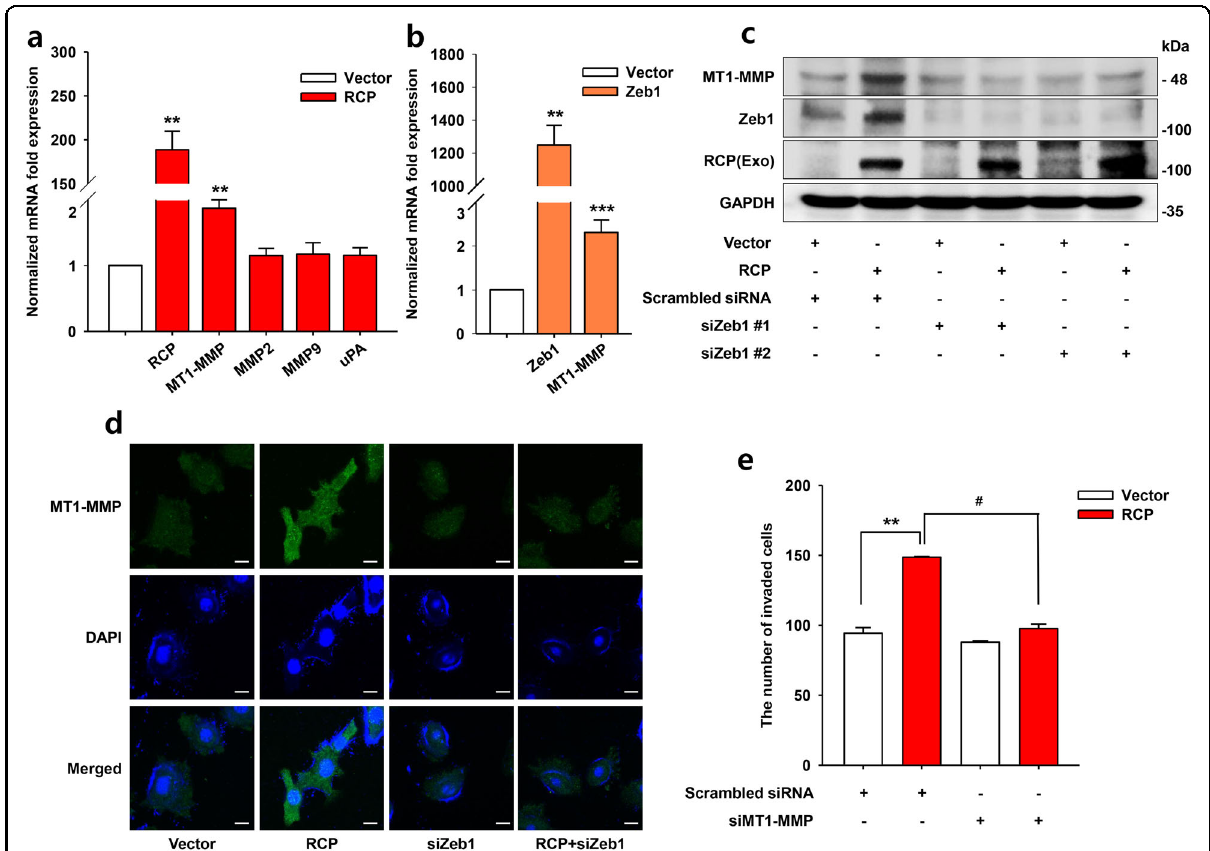
Fig. 5 RCP induces MT1-MMP to promote OSCC invasion. a , b YD-10B cells were transfected with or without ( a ) RCP and ( b ) Zeb1. qRT-PCR analysis of matrix metalloproteinases (MMP2, MMP9, MT1-MMP) and urokinase-type plasminogen activator (uPA) mRNA (error bars, ±SD: *** p < 0.001 and ** p < 0.01 vs control vector). c YD-10B cells were transfected with the indicated vectors and siRNAs. Immunoblotting. d The expression of MT1- MMP was visualized by immuno fl uorescence. Image original magni fi cation, ×600, scale bar, 10 μ m. e YD-10B cells transfected with the indicated vectors and siRNAs. Cell invasion assays were performed with media without any attractant as the control (error bars, ±SD: ** p < 0.01 vs control vector, # p < 0.05 vs RCP). The results shown are representative of three experiments with similar results and indicate the mean ± SD of three